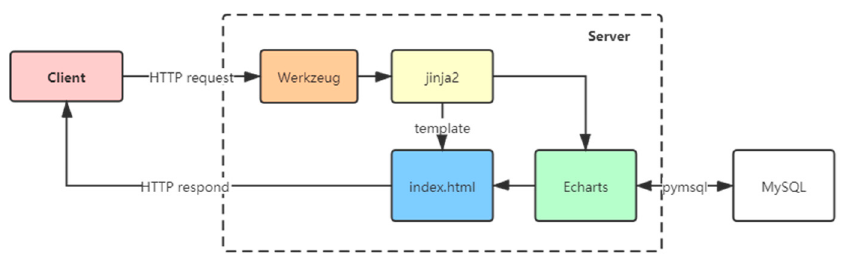
Figure 3. Webpage response flow chart under the Flask framework.